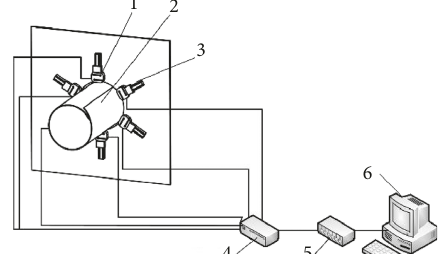
Figure 6: Schematic diagram of experimental test. 1, pressure transducer; 2, conveyor belt; 3, linear feed guide; 4, signal processor; 5, paperless recorder; 6,